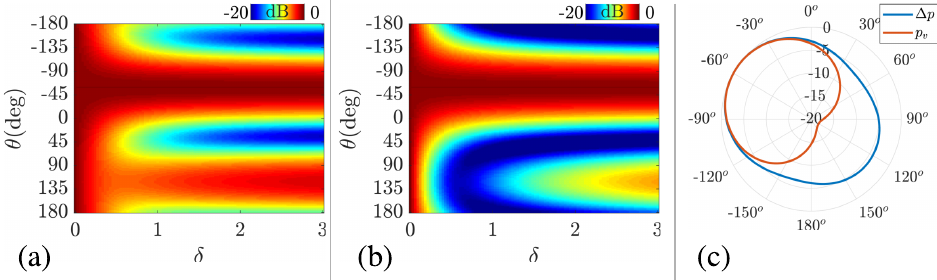
Figure 4. Energy detection for varying δ for station 3 using ∆ p ( a ) and p v ( b ). In ( c ), the beam response for ∆ p and p v is compared for δ =